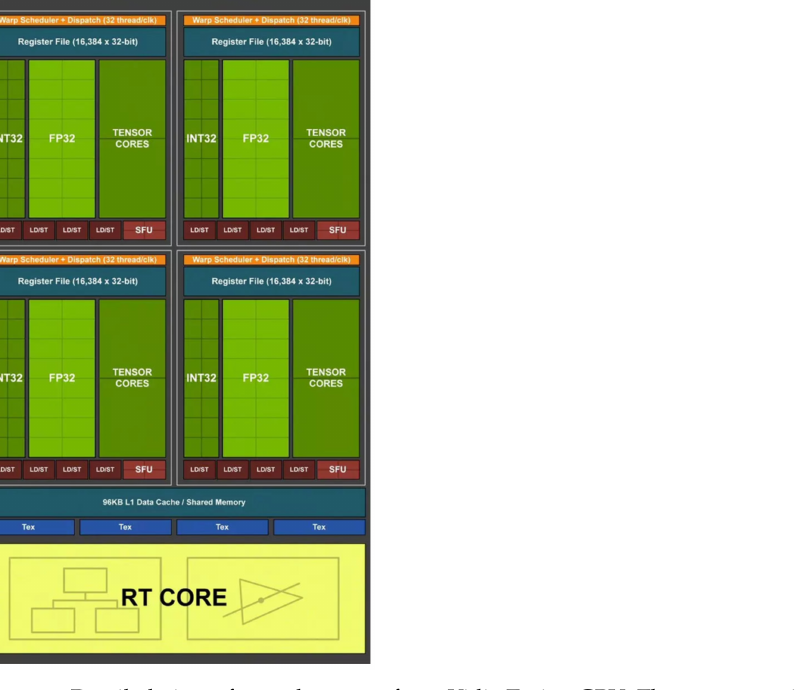
Figure 3. Detailed view of a work group of an nVidia Turing GPU. The group consists of arithmetic cores split into two subgroups and several support units that perform advanced mathematical operations (such as trigonometric operations)